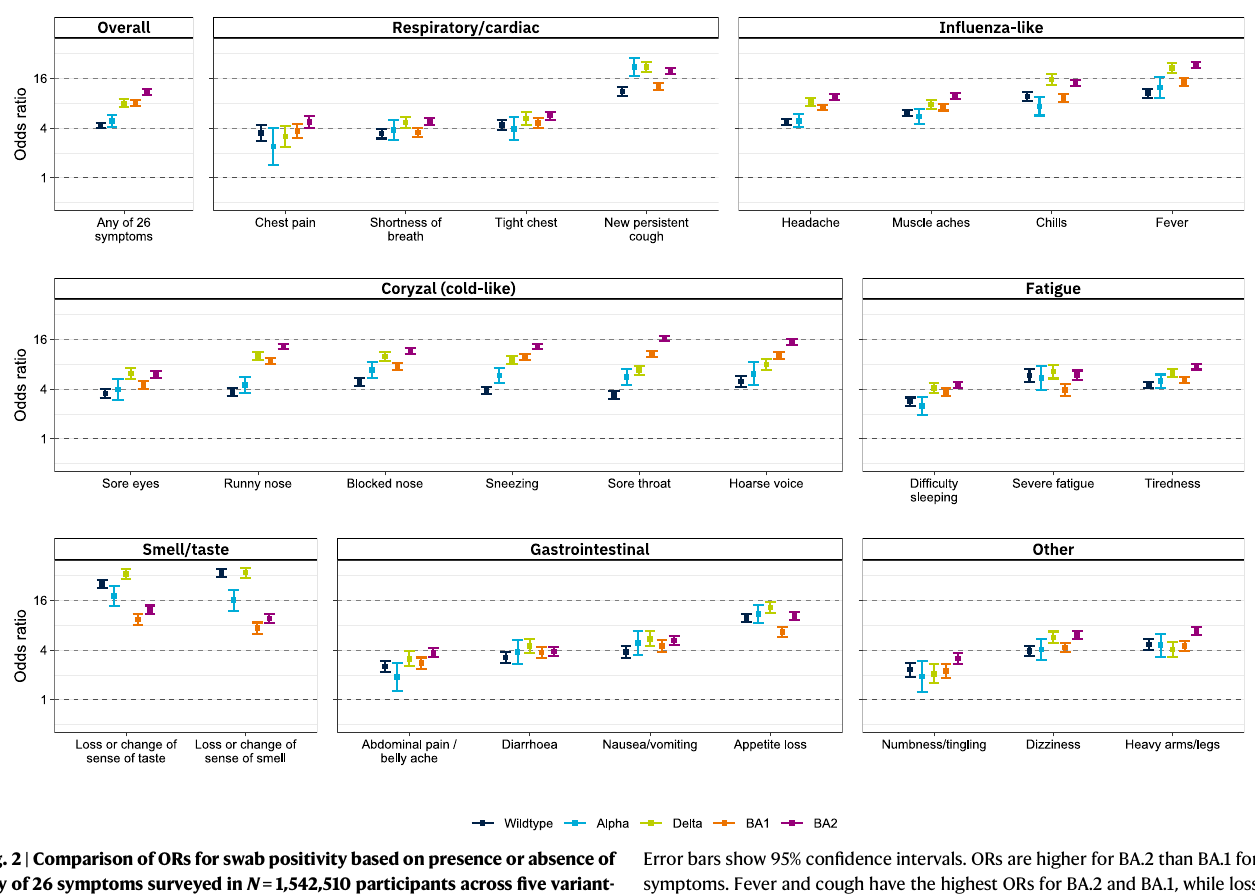
Error bars show 95% con fi dence intervals. ORs are higher for BA.2 than BA.1 for all symptoms. Fever and cough have the highest ORs for BA.2 and BA.1, while loss or change of smell or taste have the highest ORs in all previous